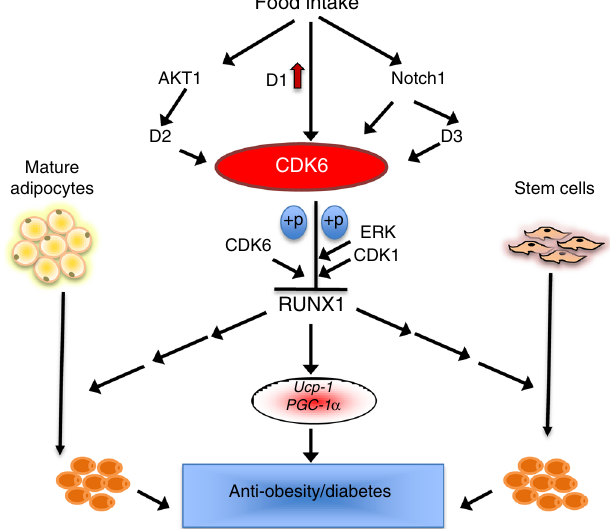
Fig. 9 A working model of the role of CDK6 in negative regulation of white fat browning by suppressing RUNX1. In response to food intake, increased expression of cyclin D1 38 and CDK6 leads to activation of CDK6 (Supplementary Fig. 1). In addition, the canonical cascade of events is initiated, including the activation of Notch1 39 and AKT1 40 . Notch1 activates CDK6 via upregulation of CDK6 and/or by increased cyclin D3 protein 41 . AKT1 activates CDK6 by stabilizing cyclin D2 42 . Phosphorylation of RUNX1 by CDK6 and other kinases such as ERK and CDK1 10 promotes